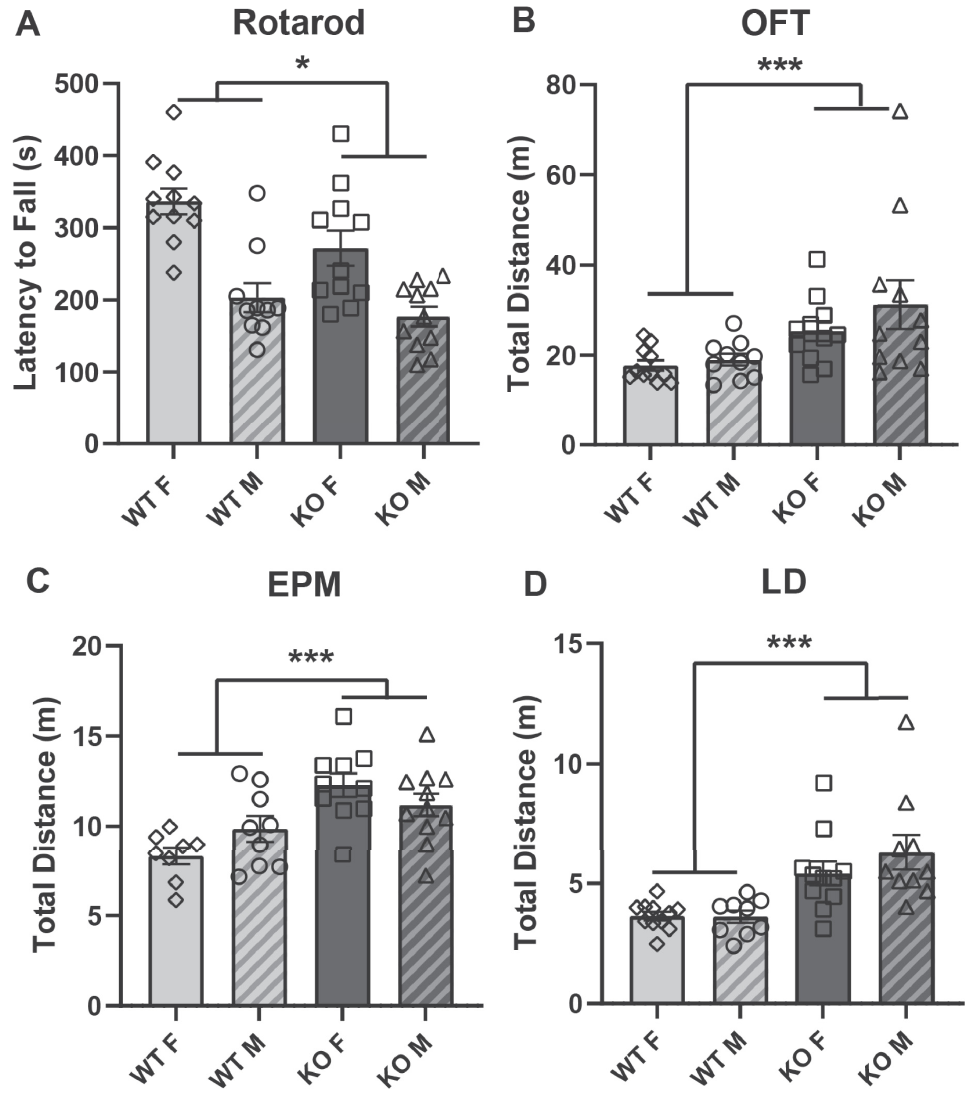
Fig 5. α 2 δ -4 KO mice exhibit alterations in motor behavior. For WT and α 2 δ -4 KO mice, graphs show the latency to fall in the rotarod assay (A) and total distance traveled in the OFT (B), EPM (C), and LD (D) assays. Rotarod: Genotype F 1 , 39 = 6.457, p < 0.05; Sex F 1 , 39 = 22.543, p < 0.001; Genotype:Sex F 1 , 39 = 1.806, p = 0.1867 by one-way ANOVA. � p < 0.05; �� p < 0.01; ��� p < 0.001 by Kruskal-Wallis and one-way